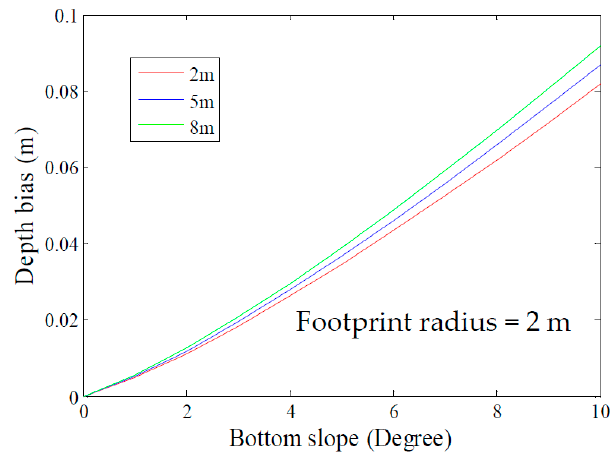
Figure 7. Effect of the bottom slope on depth bias.